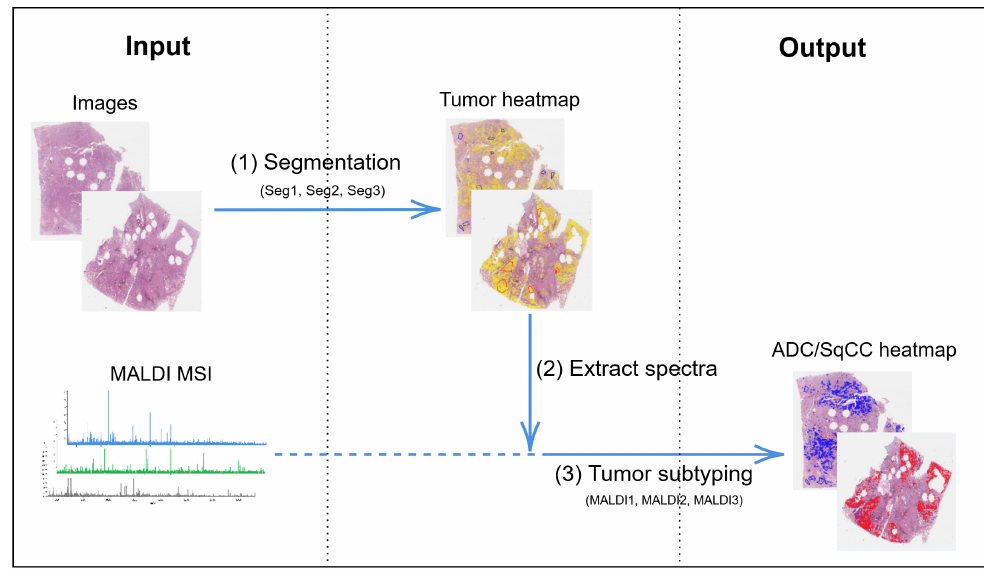
Figure 1. Overview of classification algorithm. Seg1, Seg2, Seg3 and MALDI1, MALDI2, MALDI3 refer to the different trained networks, cf. Section 2.2.2. MALDI MSI: matrix-assisted laser desorp- tion/ionization mass spectrometry imaging, ADC: adenocarcinoma, SqCC: squamous cell